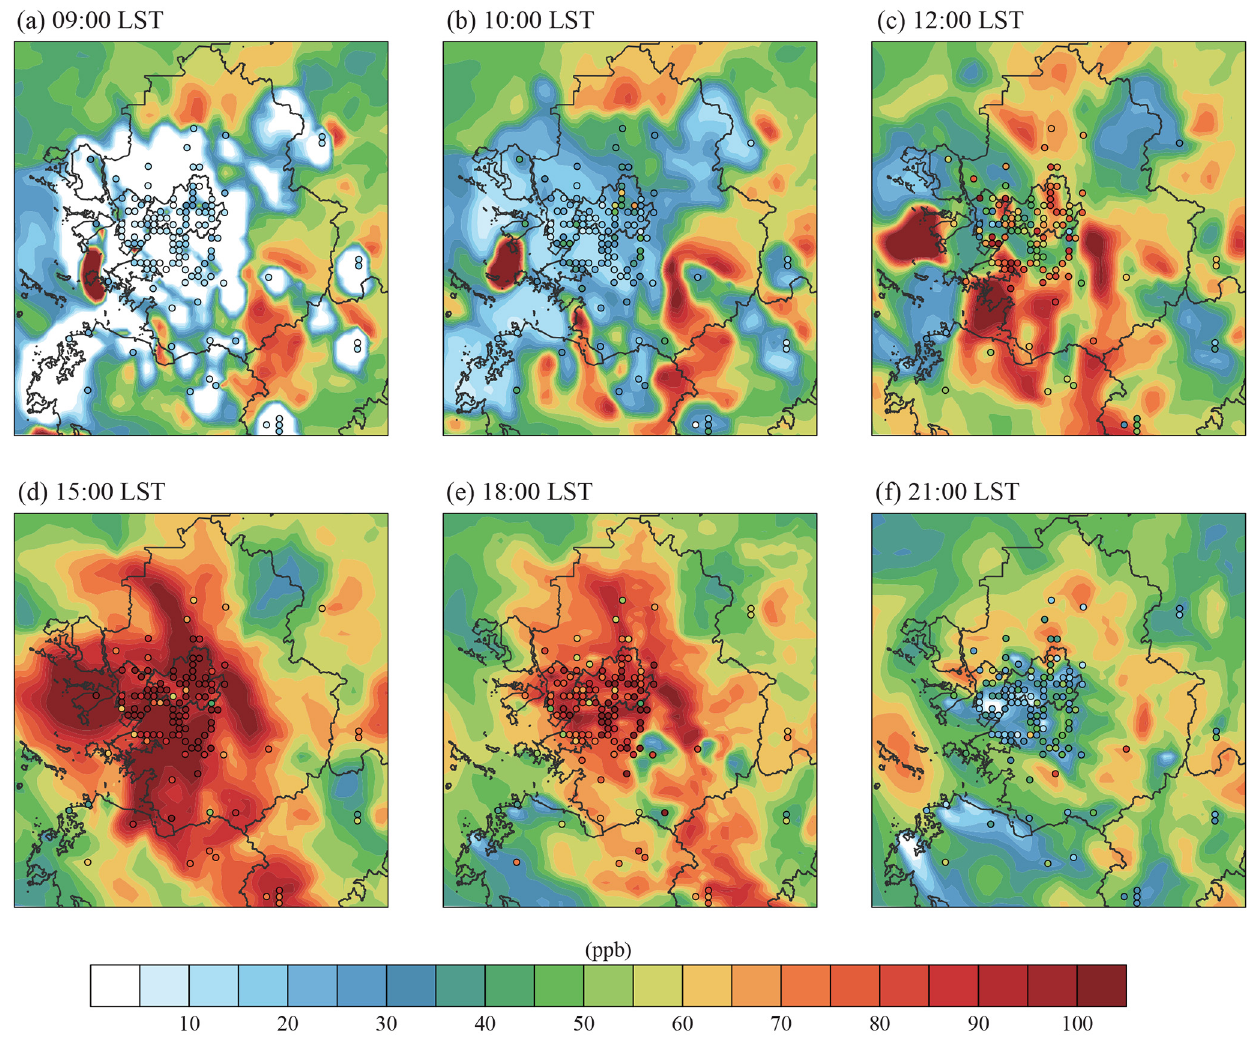
Figure 16. Horizontal distributions of surface ozone and its time variations. The plotted time is valid at (a) 09:00, (b) 10:00, (c) 12:00, (d) 15:00, (e) 18:00, and (f) 21:00LST on 5 August. Contour value stands for simulated results of 4DV experiment and the filled circles with the same color scale as the contours indicate observed